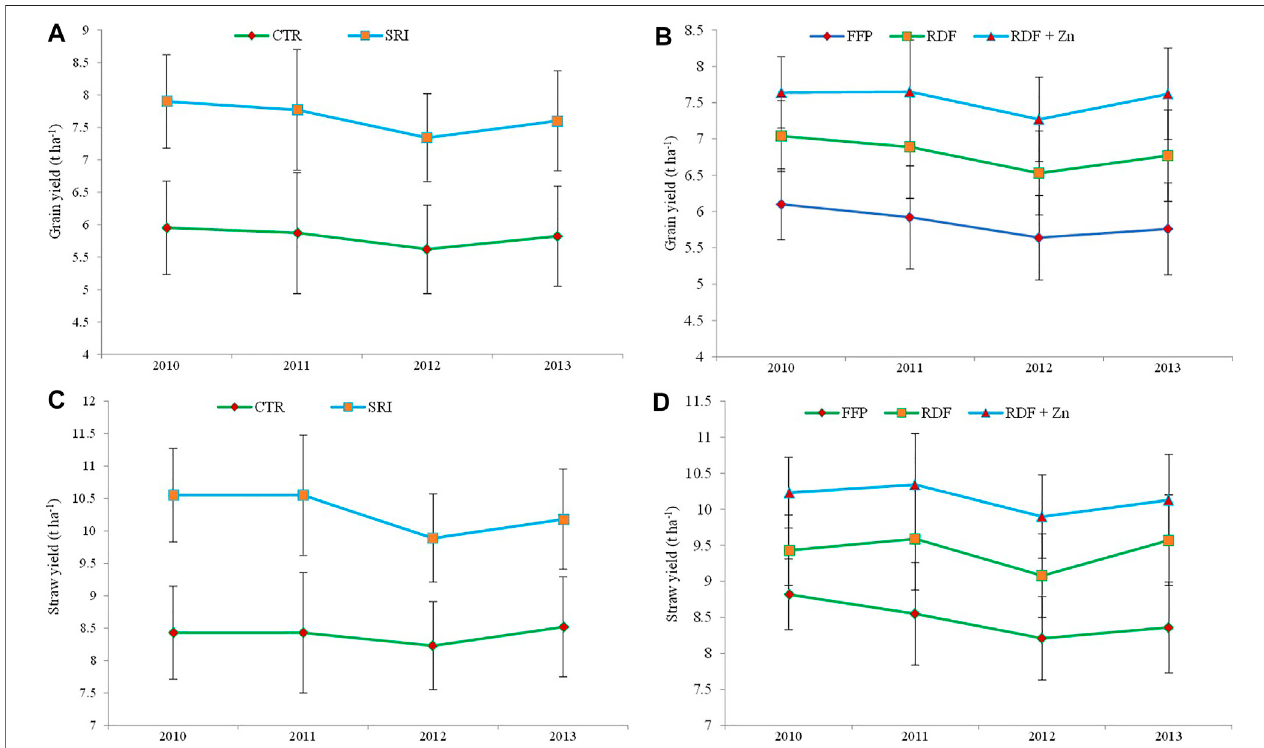
FIGURE 3 | Four years ’ rice grain (A,B) and straw (C,D) yield trend of the rice under different CEMs and NMPs. The vertical bars indicate the LSD at p = 0.05.